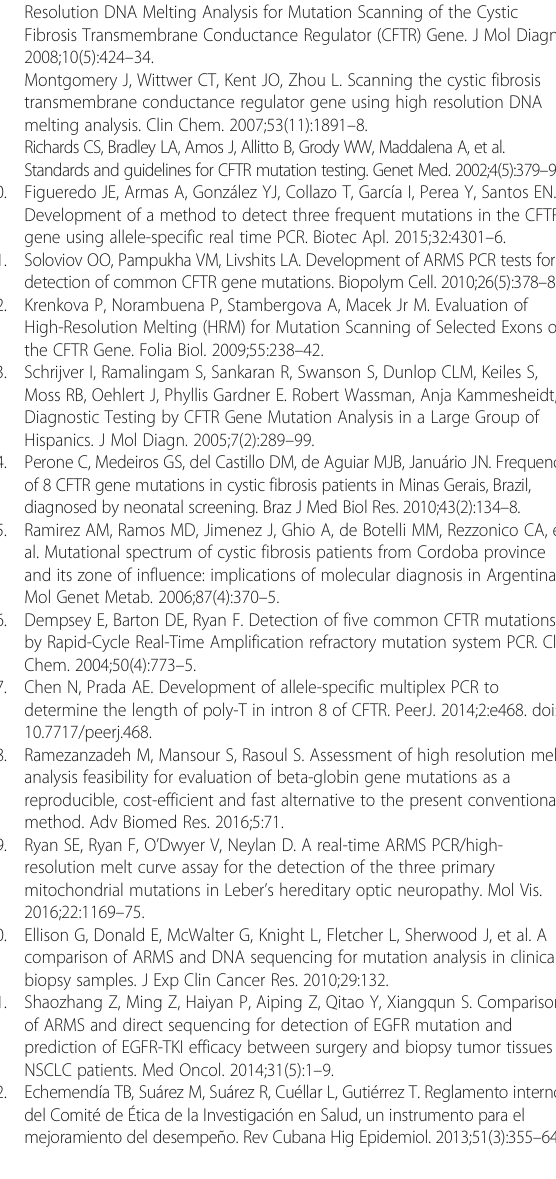
Abbreviations ARMS: Amplification Refractory Mutation System; CF: Cystic